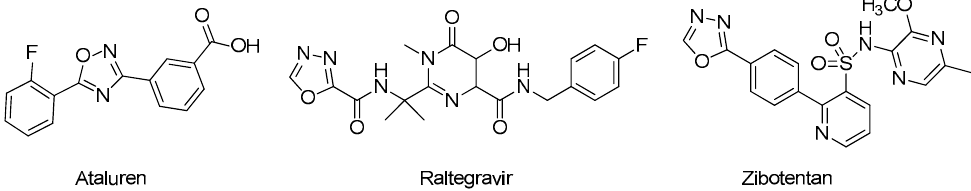
Figure 7. Structures of oxadiazole-based molecules of great interest in medicinal chemistry.